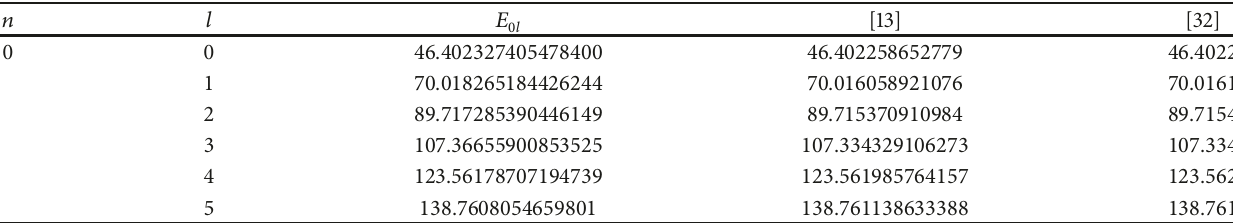
Table 6: Comparison of eigenvalues 𝑉(𝑟) = −1/𝑟 + 100𝑟 for 𝑙